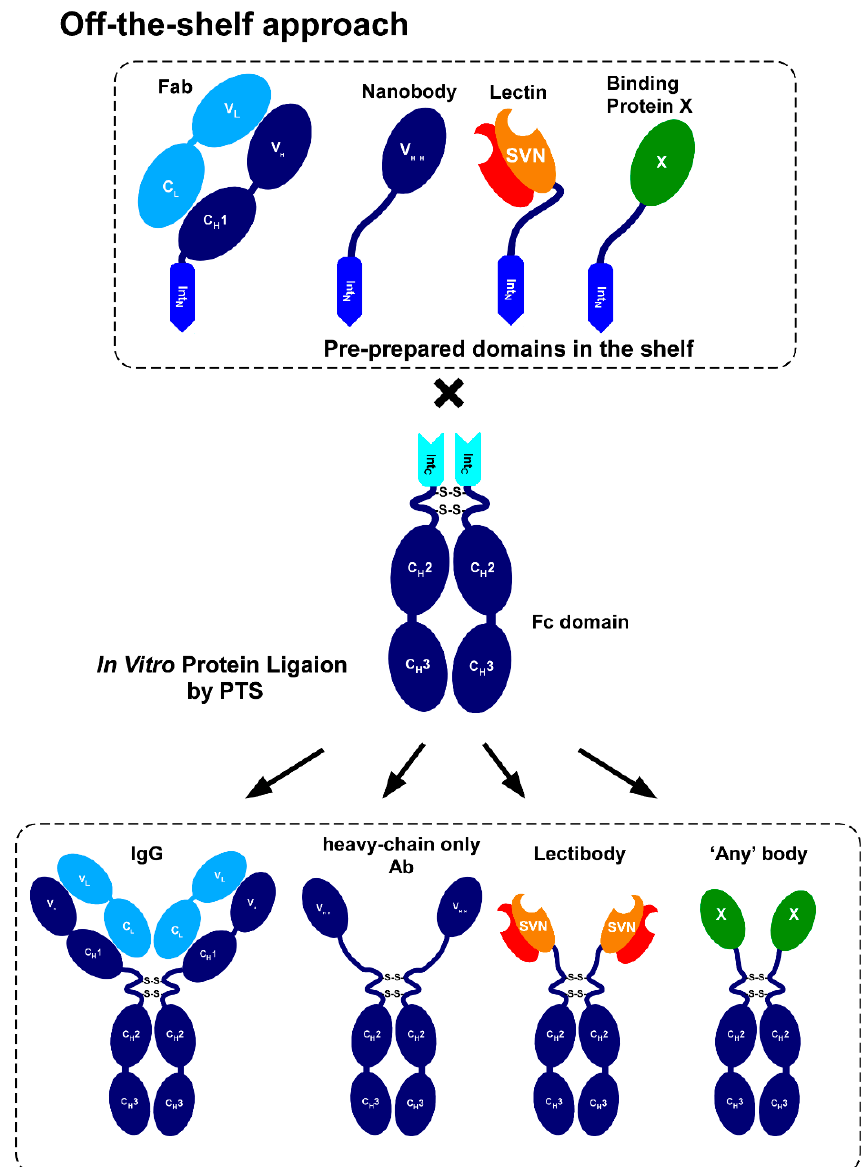
Figure 3. O ff -the-shelf approach for in vitro production of Fc fusion by protein ligation. Various binding domains (protein of interest, POI), such as lectins and V H H, fused with Int N are separately prepared. The Fc domain fused with Int C is also individually made. The N-terminal POI and C-terminal Fc domain are ligated in vitro by PTS, concomitantly splicing out the two intein fragments Int N and Int C . The ligated Fc fusion is a bivalent Y-shape molecule like an IgG